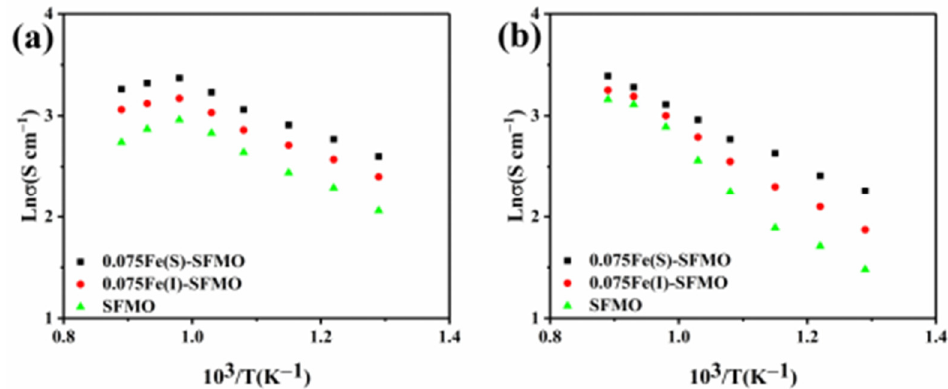
Figure 5. Conductivity of the samples. Total conductivity of SFMO materials in ( a ) air and ( b ) 5% H 2 /Ar.